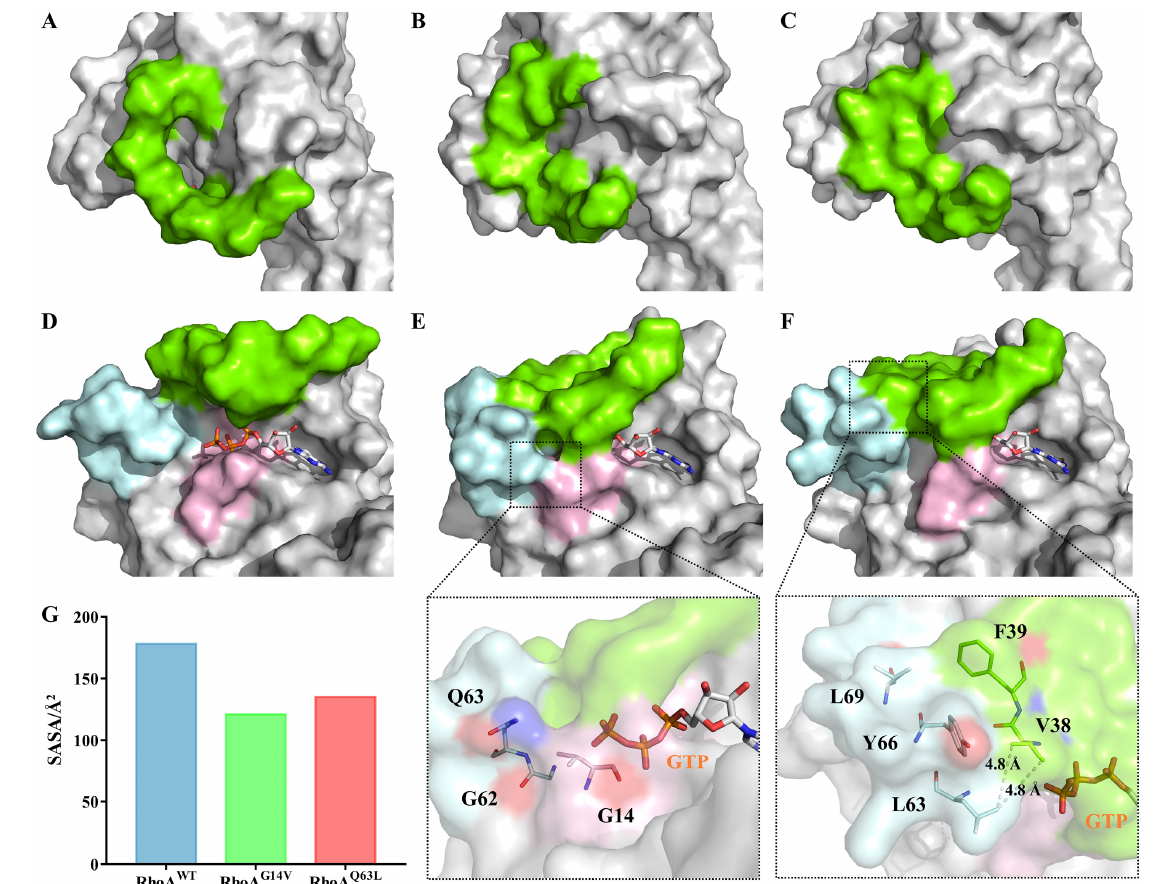
Figure 7. Differences in the protein surface properties between the wild-type RhoA and the mutants. ( A – F ) Surface of the three functional regions switch I (green), switch II (cyan), and P-loop (pink) in RhoA WT -GTP ( A , D ), RhoA G14V -GTP ( B , E ), and RhoA Q63L -GTP ( C , F ). In ( E , F ), the regions where the mutants cause critical changes are focused and magnified, with the key residues labeled and shown as sticks. All structures used here are extracted from the final snapshots (200 ns) of the MD trajectories for each system. ( G ) The SASA (Å 2 ) of GTP in RhoA WT , RhoA G14V , and RhoA Q63L averaged over the last 120 ns of corresponding triple runs.